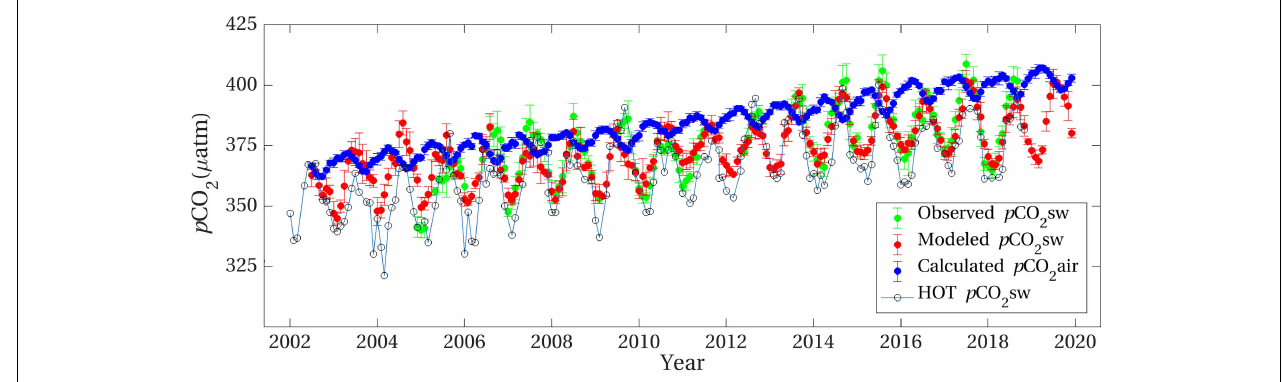
FIGURE 6 | Modeled p CO 2 sw in the full time period between 2002 and 2019, in comparison with the mooring-observed surface p CO 2 sw and calculated p CO 2 air at WHOTS. Note that the calculated p CO 2 air is based on the data of atmospheric CO 2 measured at